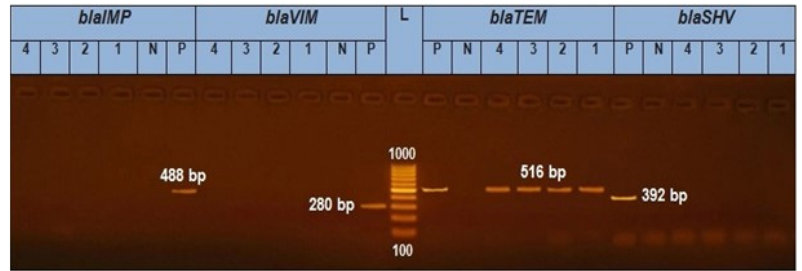
Figure 1. In total, 1.5% Agarose gel electrophoresis for PCR results of blaTEM gene in Salmonella isolates (516 bp), blaVIM (280 bp), blaIMP (488), and blaSHV (392 bp). L is a 1000 bp ladder used as a size marker. P is controlled positively. N is controlled negatively.